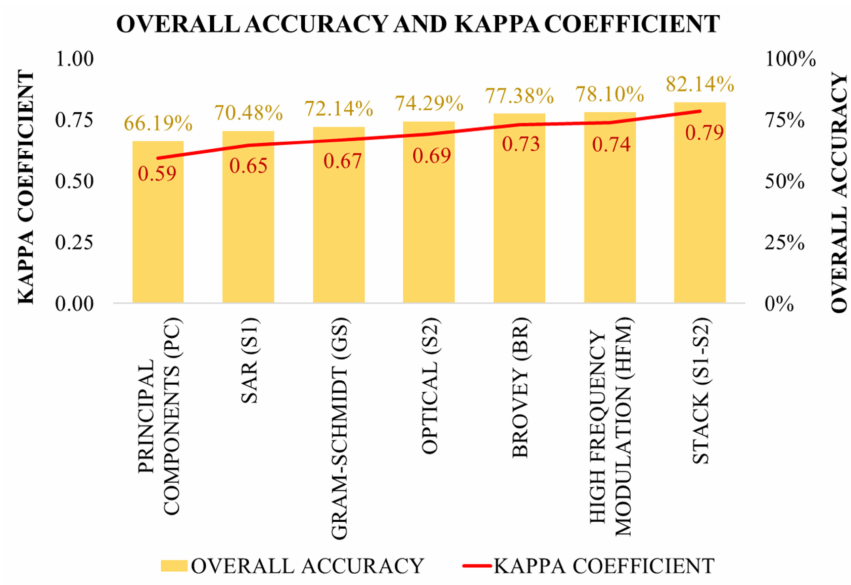
Figure 9. Comparison of overall accuracies and kappa coefficient for each of the images analyzed. The highest value was achieved for the image resulting from the optical/SAR image stack, with a value of 82.14% for the OA and 0.79 for the KC, equivalent to an increase in OA of 11.67% for the SAR image and 7.86% for the optical image. The OA obtained